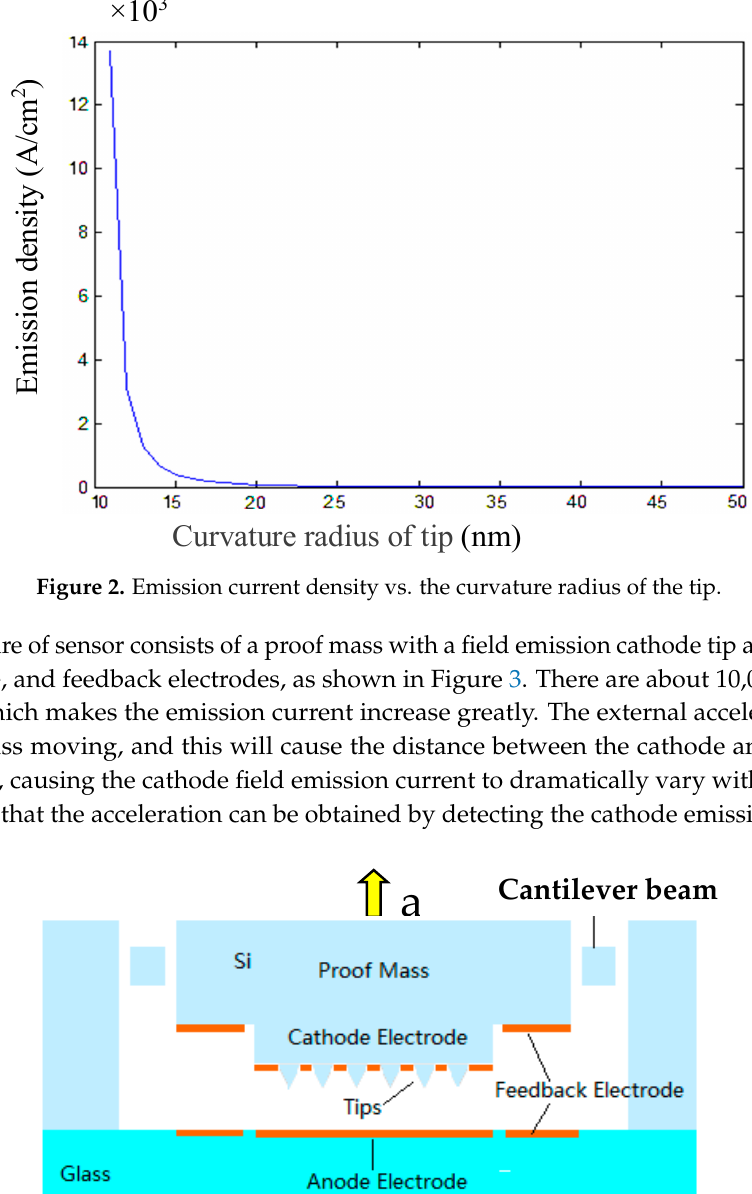
Figure 3. Structure of the vacuum microelectronic accelerometer.